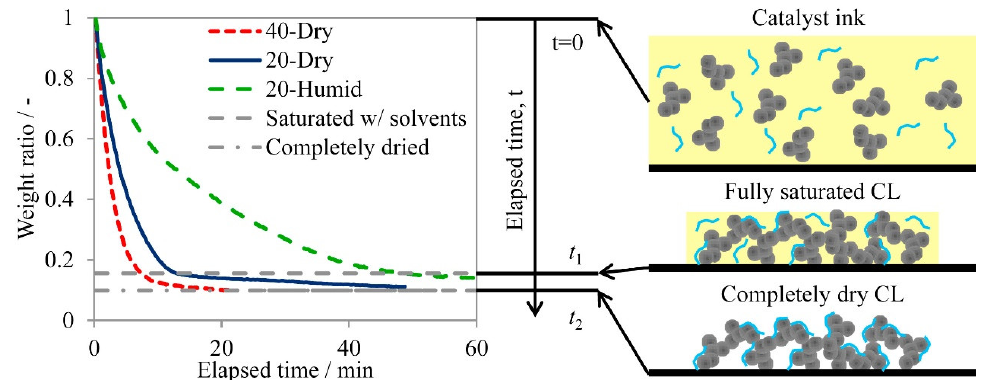
Figure 13. Weight change of the ink film at different drying conditions (20 or 40 °C, dry—0% RH, humid—80% RH) and the schematics of the structure change from the ink film to the dried CL (Reprinted from [56], Copyright (2016), with permission from Elsevier).